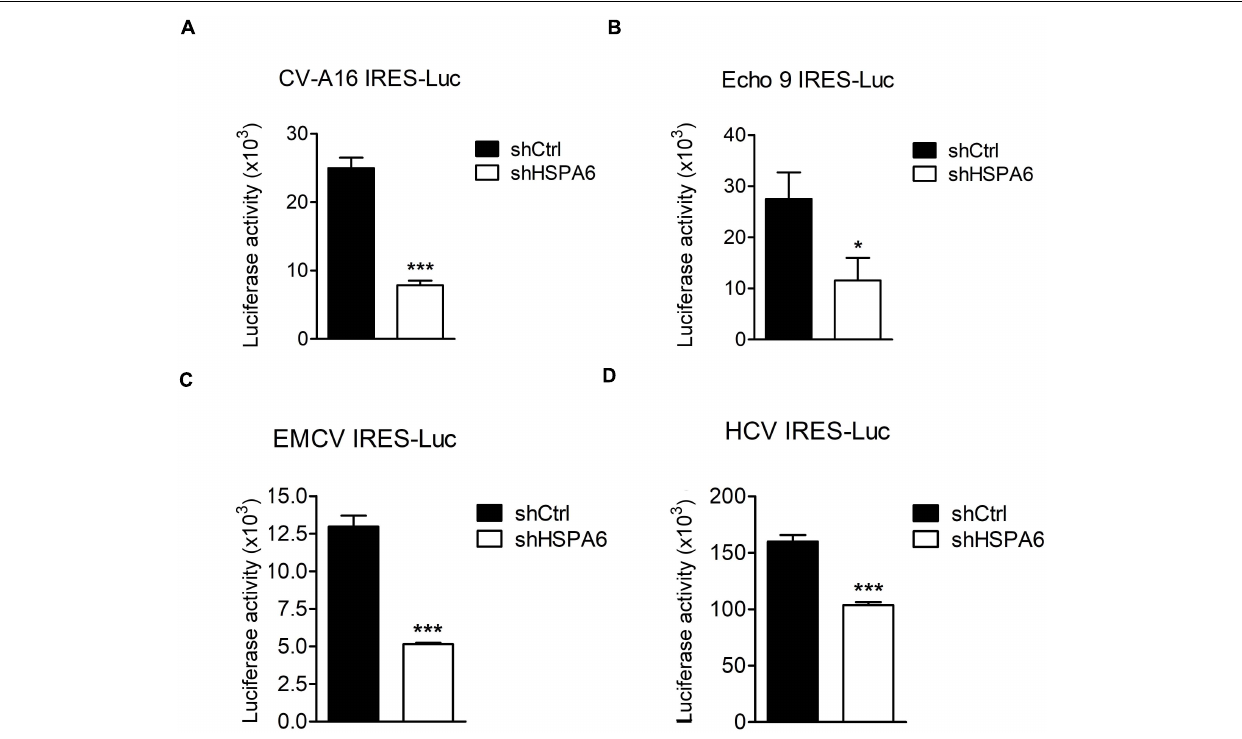
FIGURE 7 | HSPA6 facilitates IRES activities from other viruses. HeLa and Huh7 cells were first infected with shCtrl or shHSPA6 expressing lentiviruses, followed by puromycin selection for 48 h to generate HSPA6-knockdown cells. The in vitro transcribed RNA of (A) CV-A16 IRES-Luc, (B) Echo 9 IRES-Luc, (C) EMCV IRES-Luc, or (D) HCV IRES-Luc was transfected into HeLa cells, whereas the RNA of HCV IRES-Luc was transfected into Huh7 cells. Luciferase activities expressed in WT RD cells and HSPA6-knockdown cells were compared at 6 h post transfection. All the values of luciferase activity were normalized with the RNA transfection efficiency. The data were presented as means ± SD ( n = 3), and analyzed with unpaired student’s t -test. *** P < 0.001, and * P <